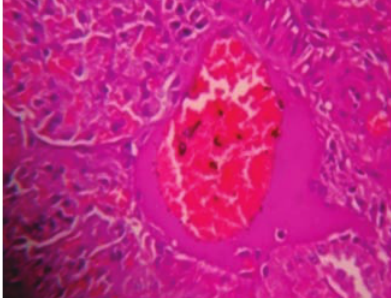
Figure 2. Liver of Kushta Sammulfar -I showing mild congestion in central vein, hepatic vein and portal triad.